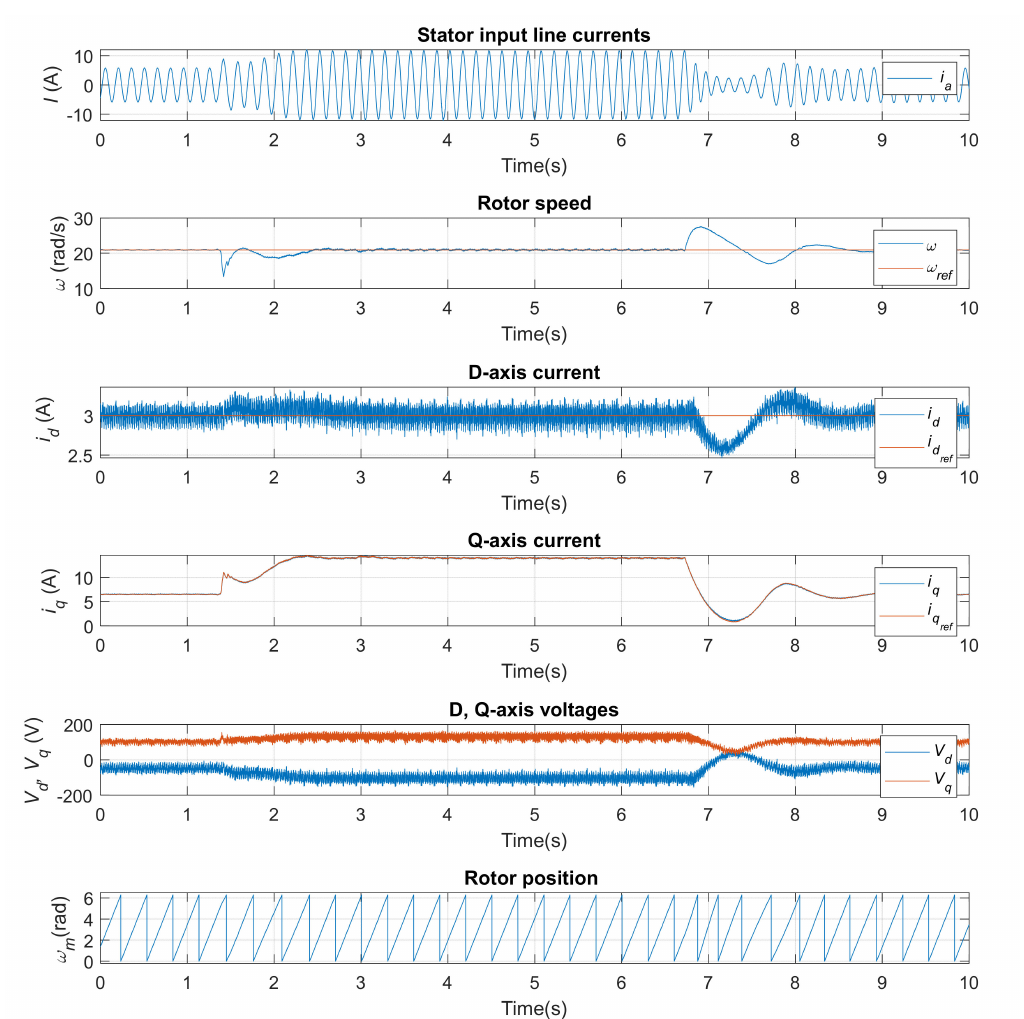
Figure 16. Step-load imposing and unloading; I a : the measured phase a current, ω : the measures speed ( ω ) and the reference speed ( ω ref ), i d : the direct axis current ( i d ) and the direct axis current reference ( i dref ), i q : the quadrature axis current ( i q ) and the quadrature axis current reference ( i qref ), V dq : the direct and quadrature axis voltages, θ m : the mechanical angle of the